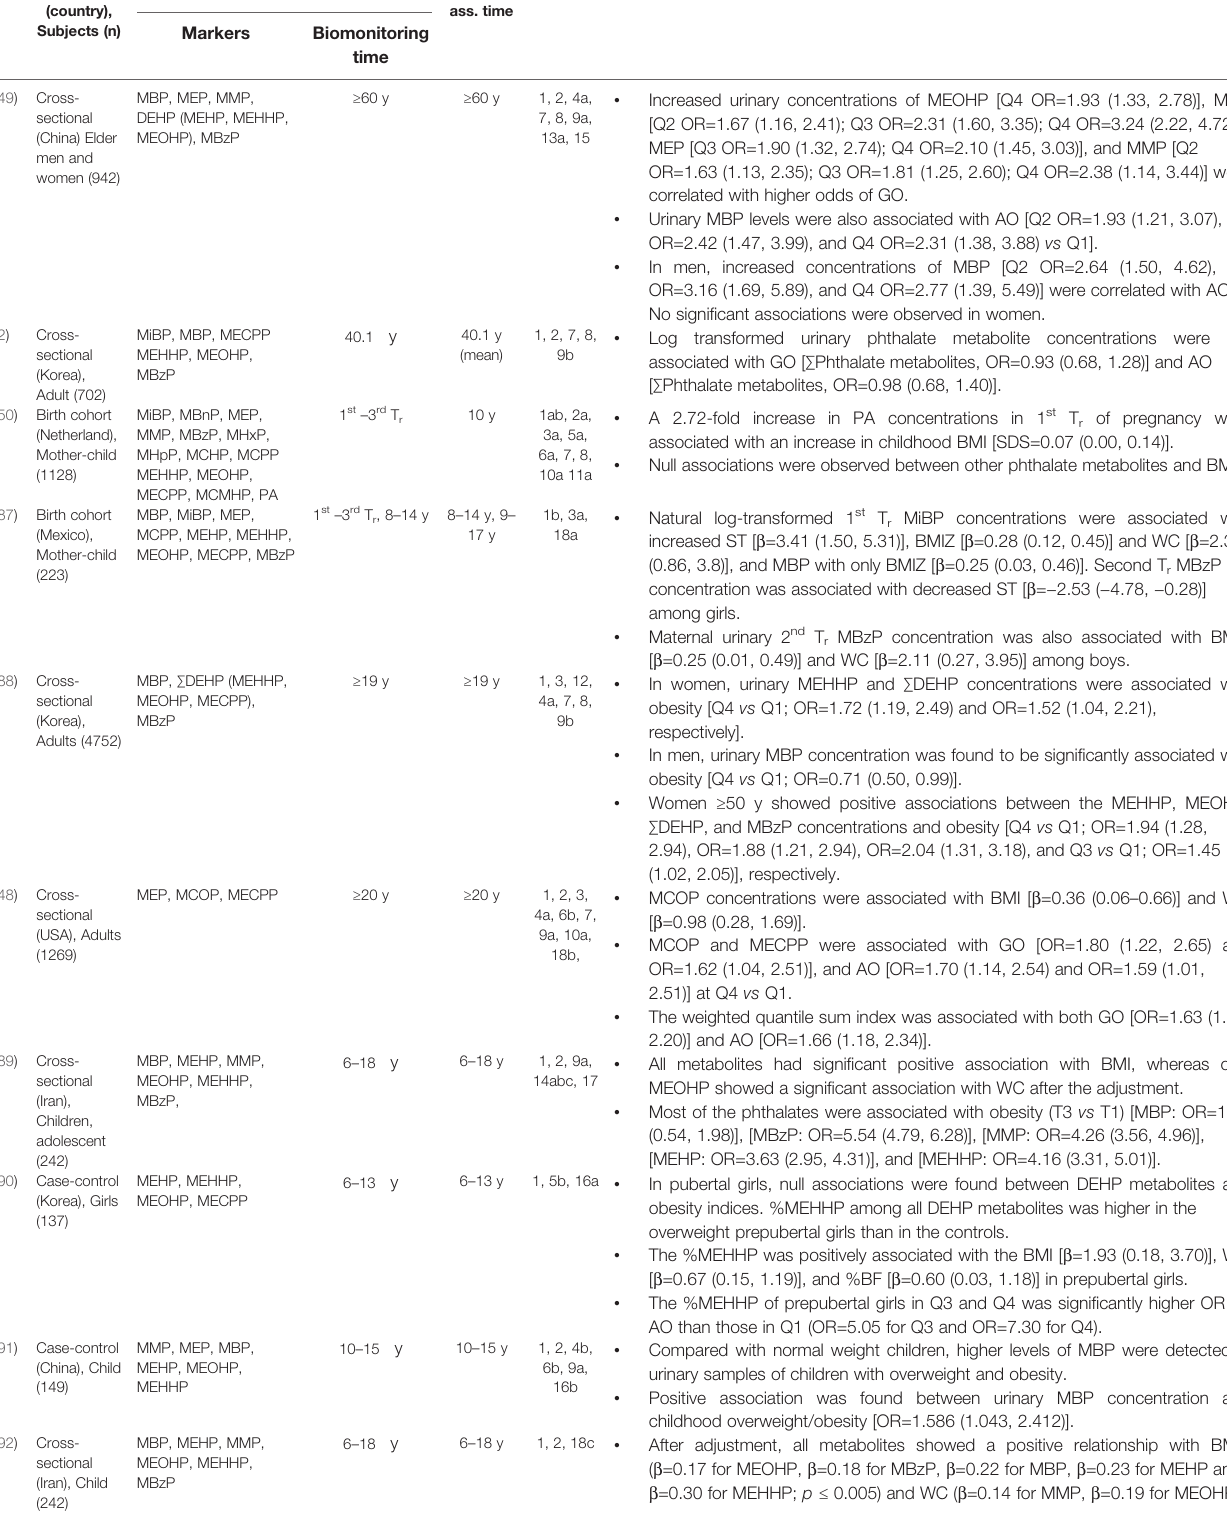
TABLE 2 | Associations of environmental phthalates with anthropometric overweight and obesity indices. Ref. Study type Exposure Key fi ndings (country), Subjects (n)